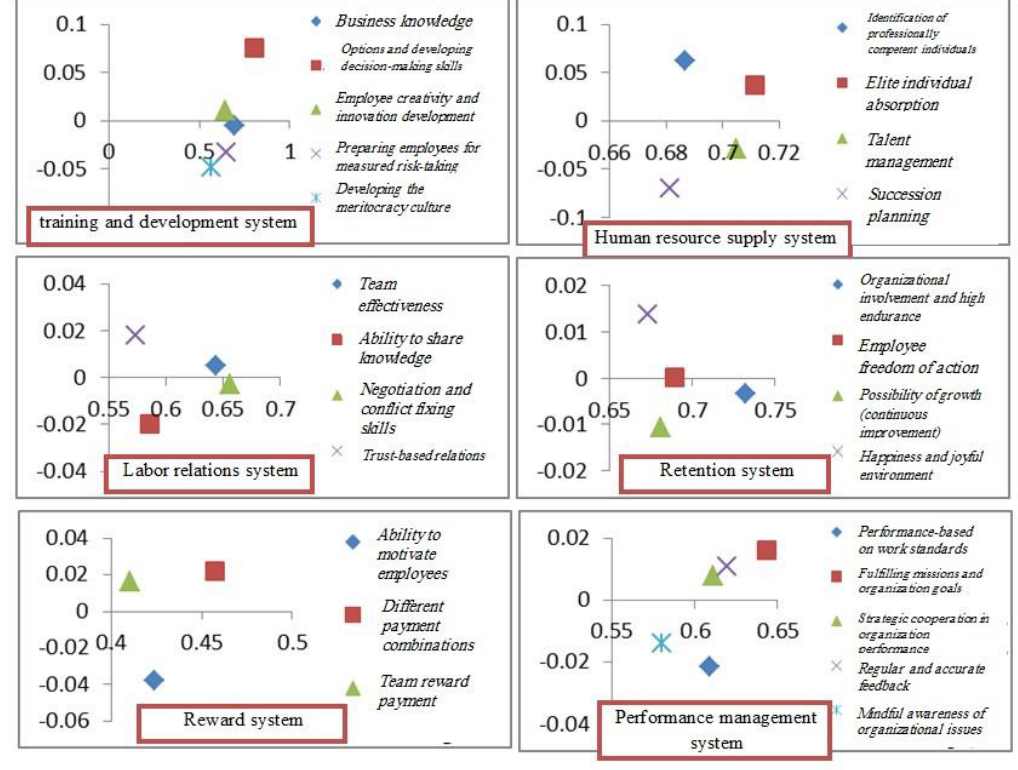
Fig. 3. Cause and effect diagram among